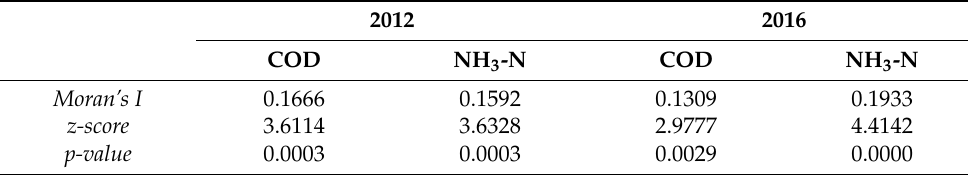
Table 2. Expected Moran’s I values of water pollutants in the Beijing–Tianjin–Hebei